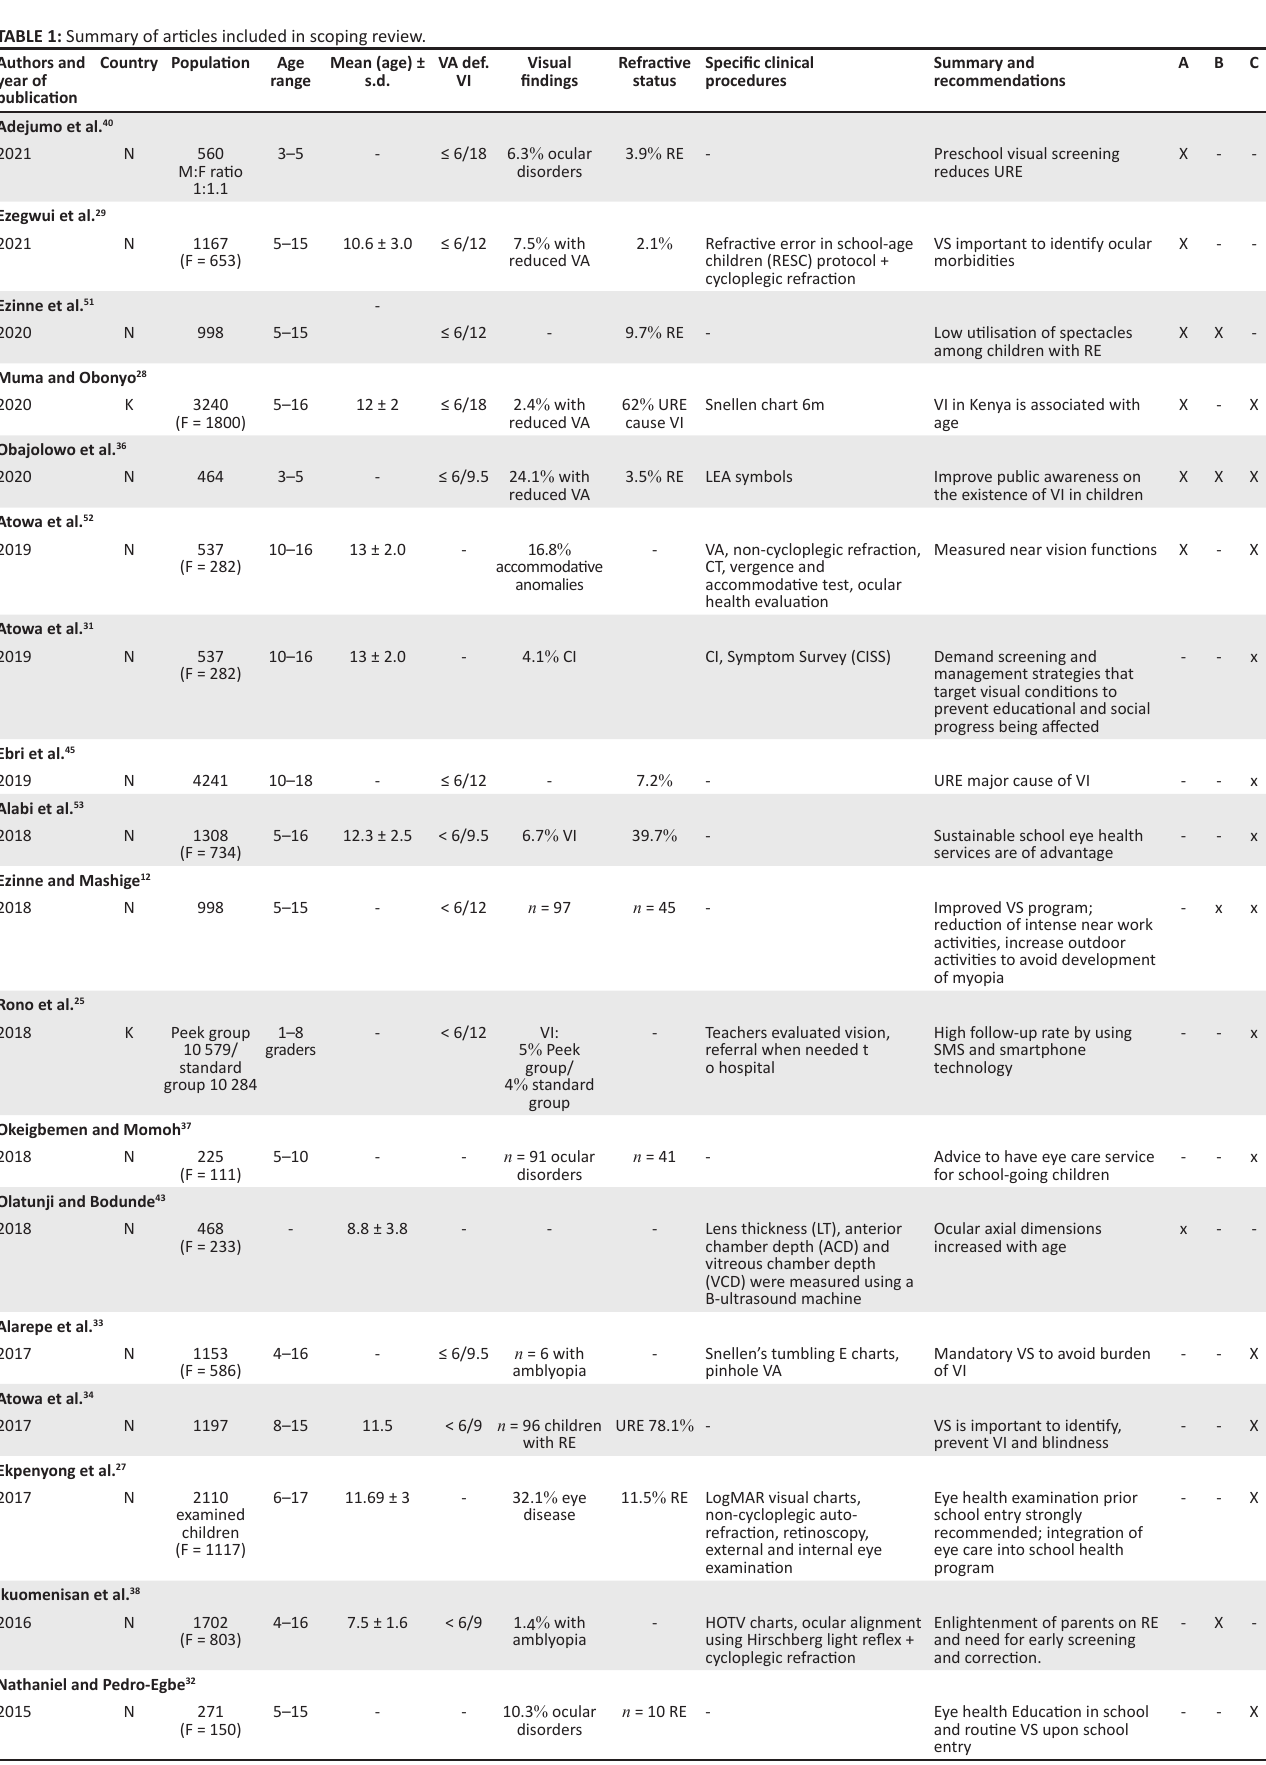
TABLE 1: Summary of articles included in scoping